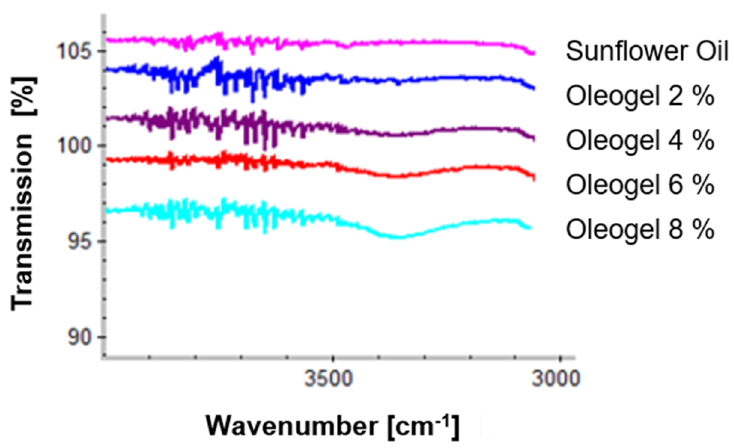
Figure 3. IR spectra of oleogels in sunflower oil with increasing TE